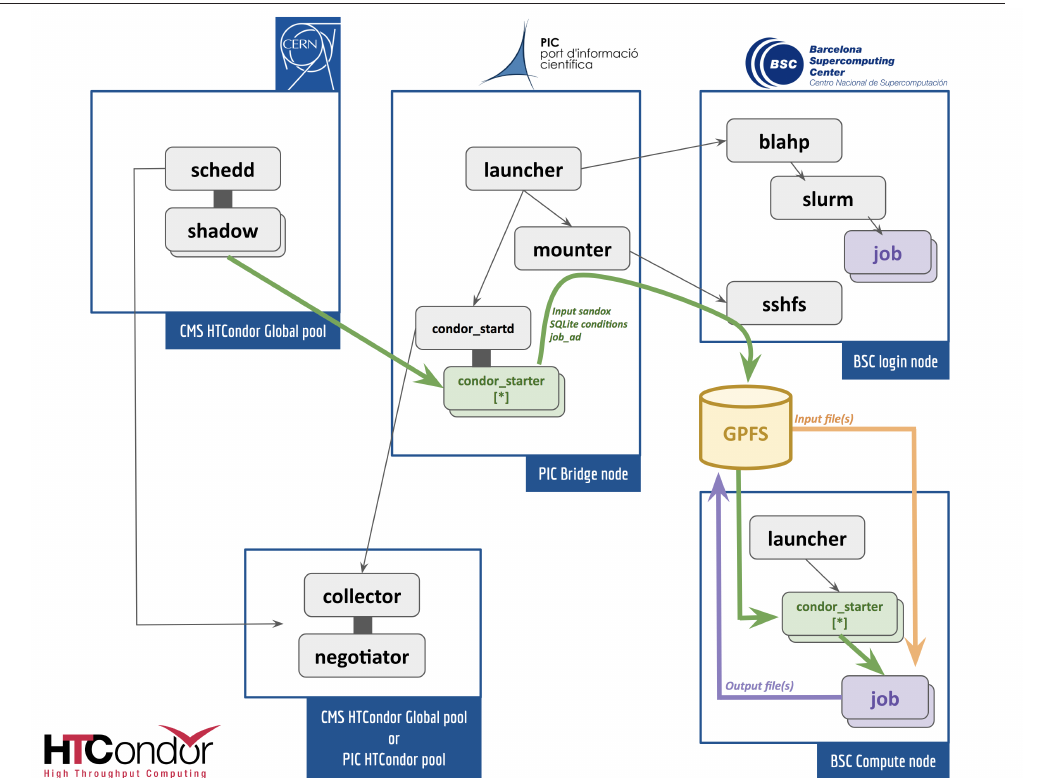
Figure 1. HPC resources at BSC integration model into CMS computing using communication via filesystem to replace